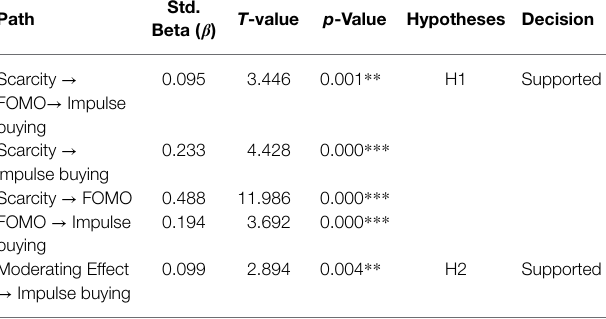
TABLE 5 | Path coefficients.